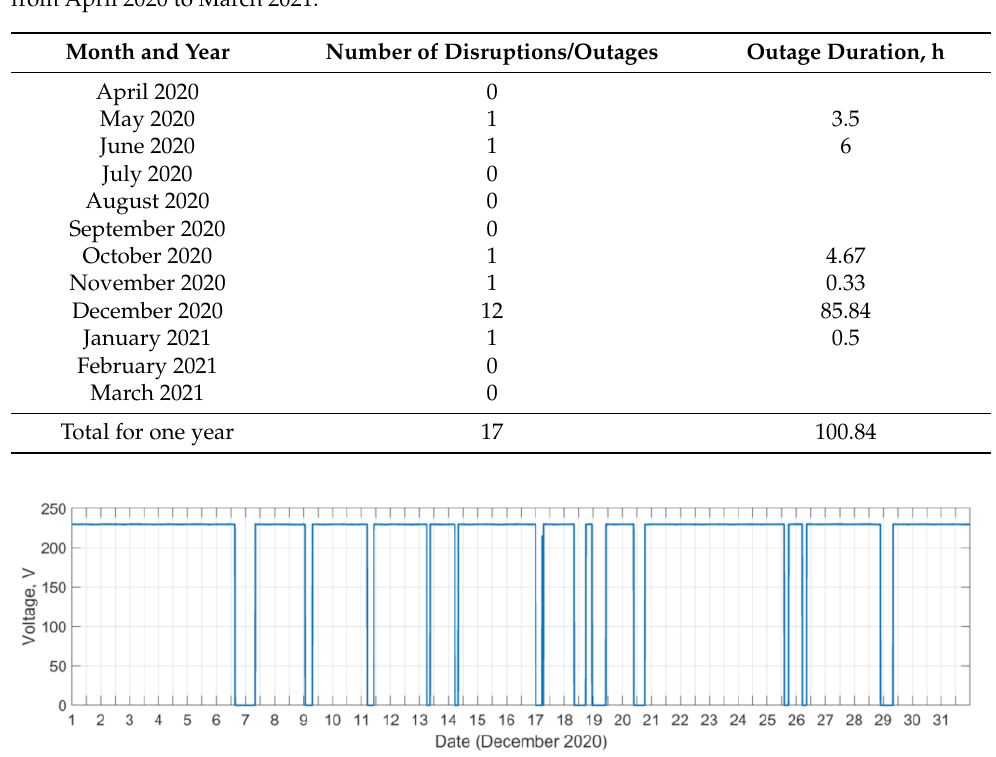
Table 11. Electricity service outages in the Gilutongan Island solar microgrid for the one year period